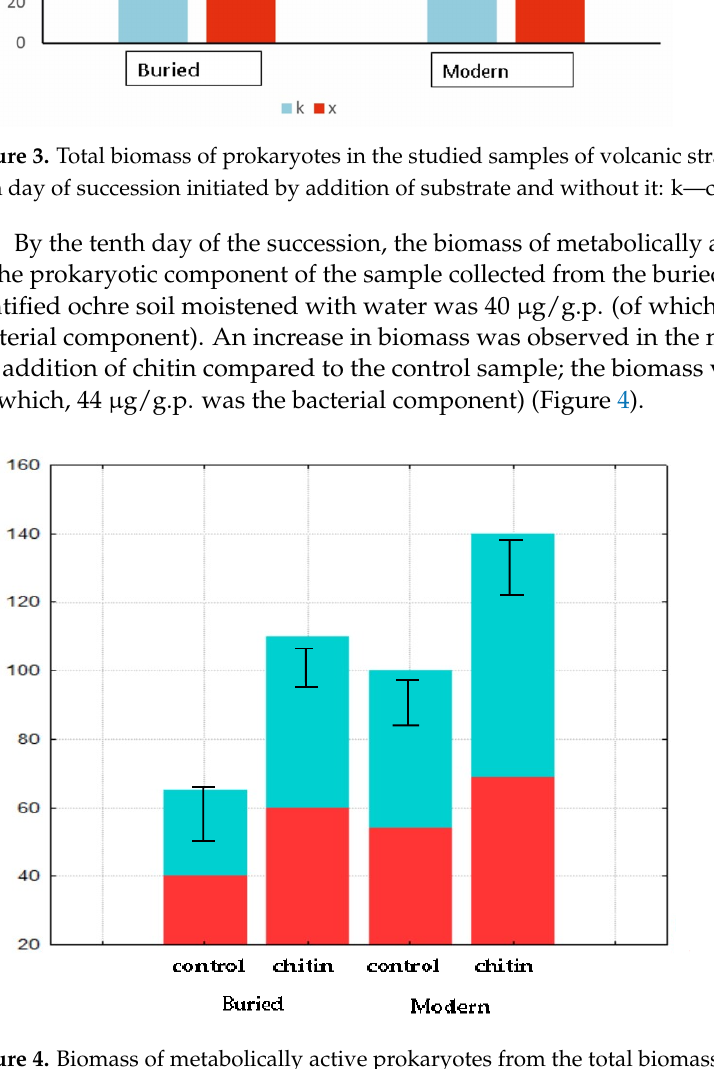
Figure 4. Biomass of metabolically active prokaryotes from the total biomass in the studied soils on the 10th day of the succession, initiated by adding substrate and without it: blue—cells unhybridized by probes; red—metabolic activity cells.